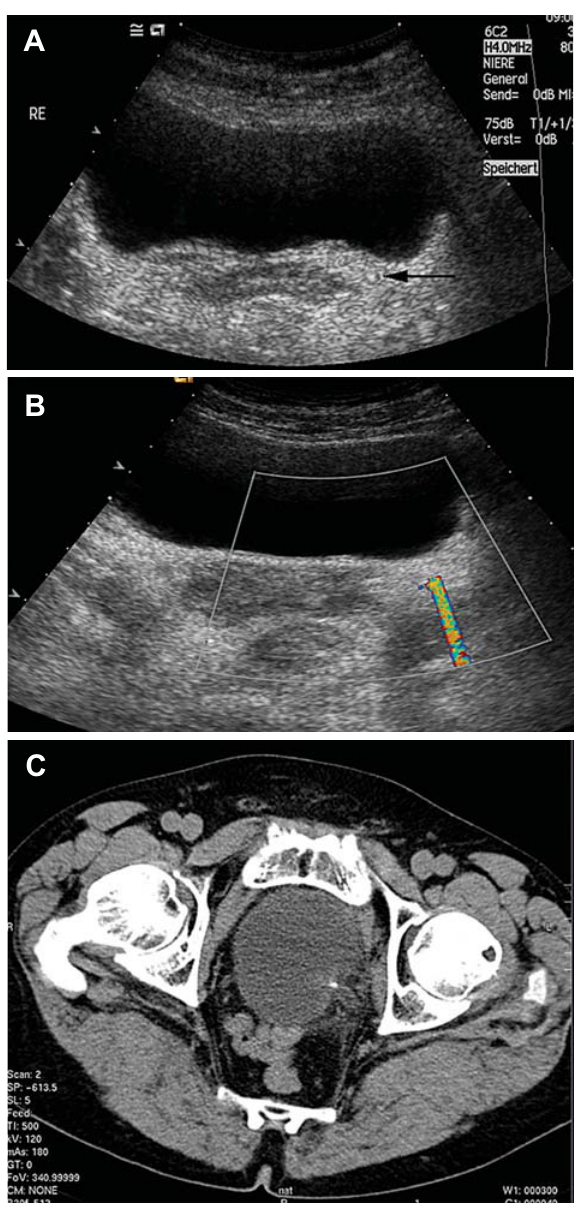
Figure 3 – Forty-six year-old woman with 5-mm stone near ureterovesical junction (UVJ). A) Axial sonogram of bladder shows that left UVJ is swollen and is slightly more echogenic compared with opposite site. However, existence of ureteral stone (arrow) is not definite because of surrounding echogenic tissue and absent posterior acoustic shadowing. B) Color Dop- pler sonogram shows prominent twinkling artifact from left UVJ area. C) Corresponding unenhanced computed tomography with clearly visible stone at the left UVJ.